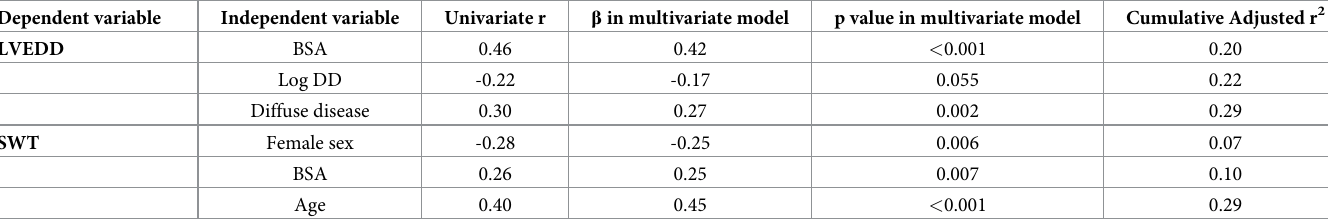
Table 4. Multivariate models of selected left ventricular structural variables in subjects with systemic sclerosis. Dependent